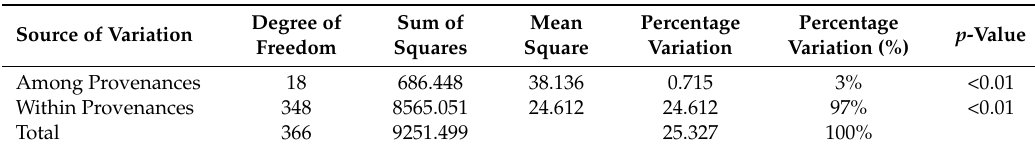
Table 4. Analysis of molecular variance (AMOVA) of the 19 black locust provenances based on SSR markers.